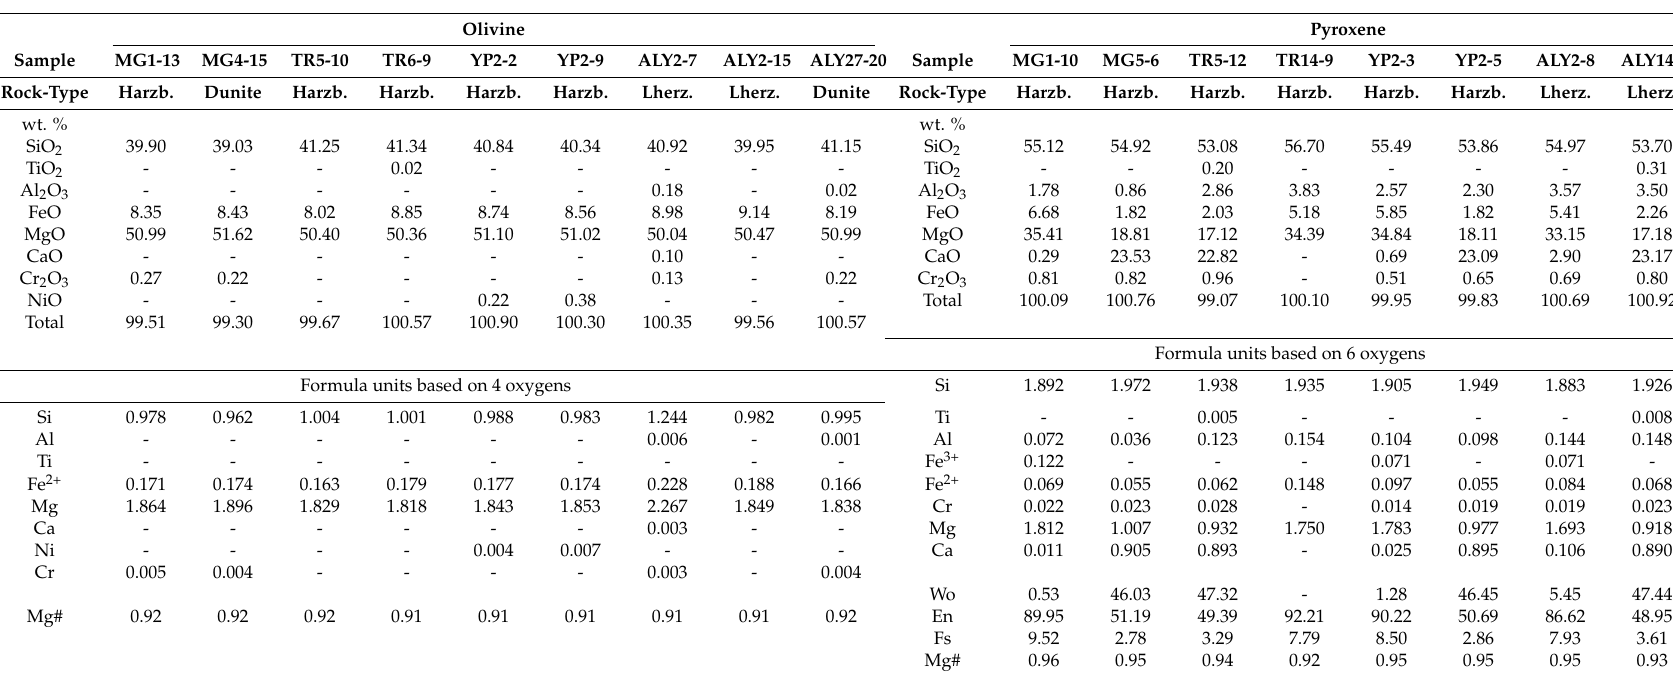
Table 2. Representative electron microprobe analyses (wt.%) and atomic proportions of olivine and pyroxene from peridotites of Megaplatanos (MG), Tragana (TR), Ypato (YP) and Alyki (ALY) study